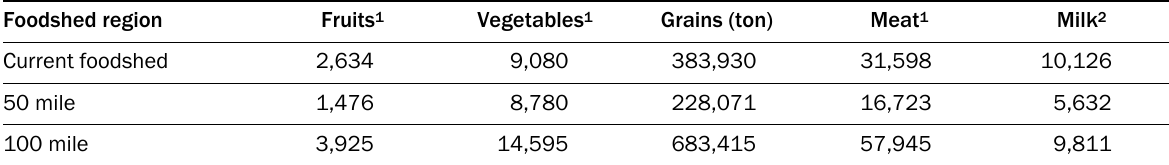
Table 8. Food Production Converted to DGA Units in Three Foodshed Regions Foodshed region